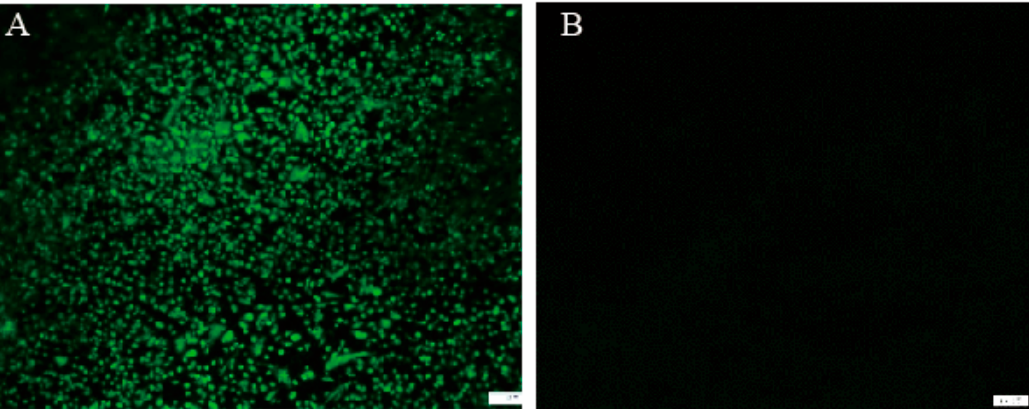
Figure 2. Expression of the gB gene in rFPV by IFA (×100 µm). CEF cells were infected with rFPV-gB or wt-FPV at MOI of 0.02. Expression of the ILTV gB gene was confirmed at 48 h post-infection with the chicken polyclonal antibody against the gB gene of ILTV by IFA. ( A ) rFPV-gB, ( B ) wt-FPV. The cells were collected for Western blot analysis after being infected with rFPV-gB or wt-FPV, and the results showed that the CEF cells infected with rFPV-gB appeared in obviously specific bands (110 kDa) when stained with a polyclonal antibody against ILTV, but no bands were found in the cells infected with wt-FPV (Figure 3).